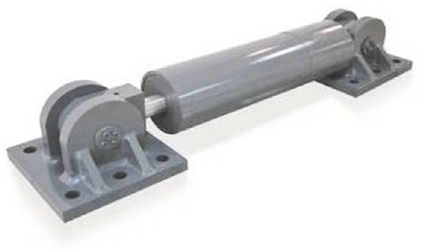
Figure 3: The fluid viscous